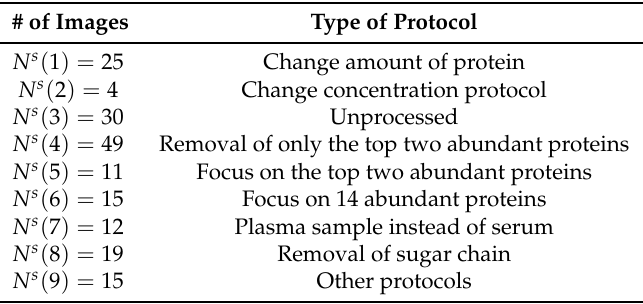
Table 2. List of source 2-DE images ( N s = 180, D s y = 9)